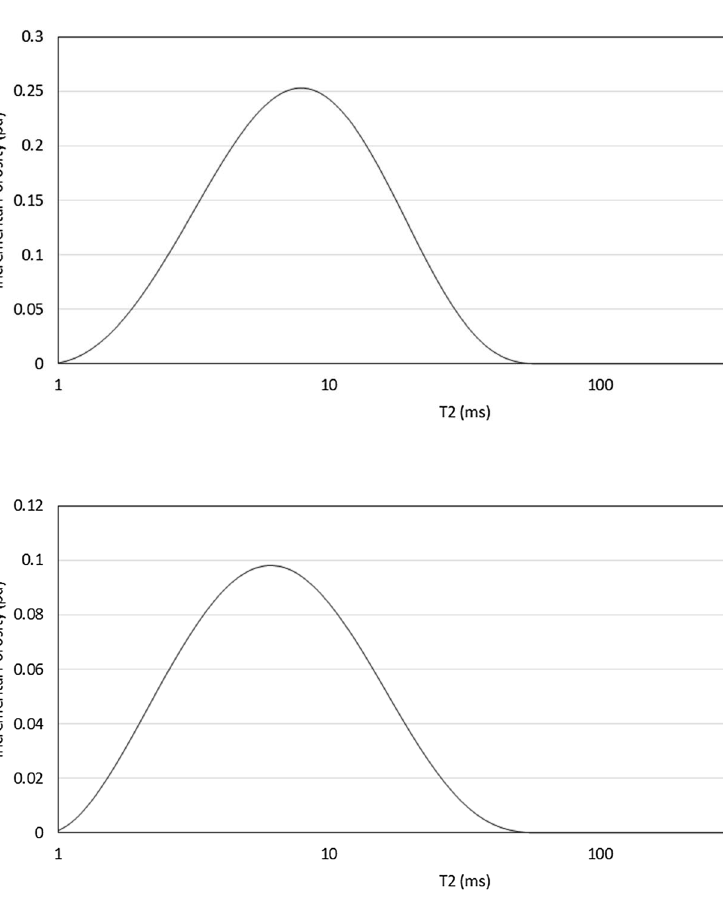
Fig. 3 Accumulative porosity curves for determination of T 2c (sample